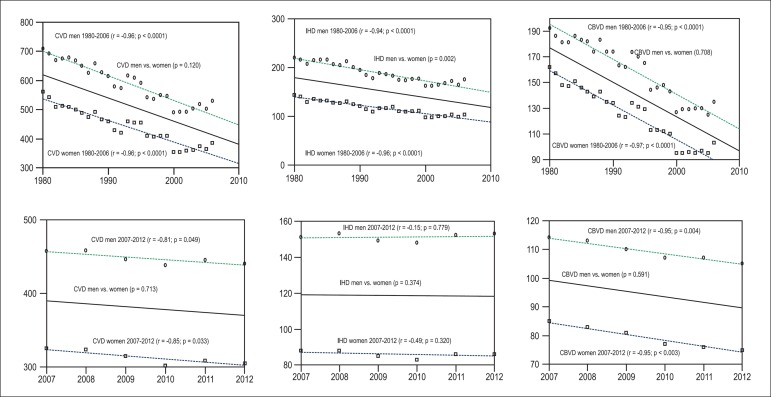
Analysis of the simple linear regression and comparison between the lines
of regression of the mortality from cardiovascular diseases (CVD),
ischemic heart diseases (IHD), and cerebrovascular diseases (CBVD)
between men and women, for the periods of 1980 to 2006 and 2007 to
2012.